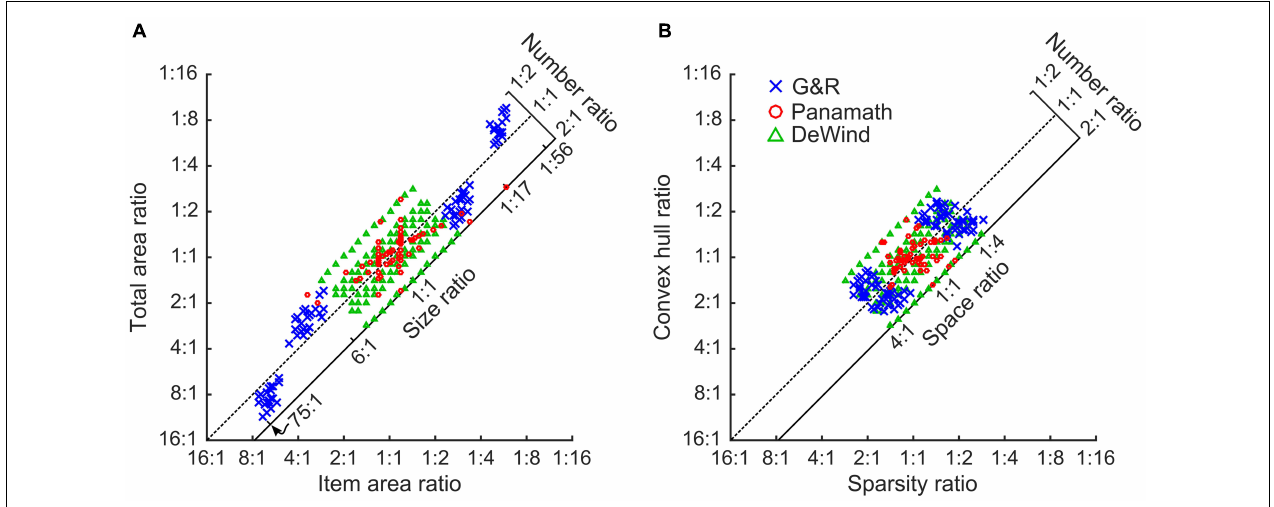
FIGURE 1 | Stimulus Space. All stimulus pairs plotted according to the left to right ratio of item area against total area (A) , and sparsity against convex hull (B) . The diagonal dotted line shows where stimulus pairs of equal numerosity would appear. Pairs farther up and to the left of both plots have a smaller left to right numerical ratio, and those down and to the right have a larger left to right numerical ratio. Pairs farther down and left have a smaller size (A) or spacing (B) ratio, and those farther up and to the right have a larger size (A) or spacing (B) ratio. Red circles are Panamath pairs, blue “x”s are G&R pairs, and green triangles are DeWind